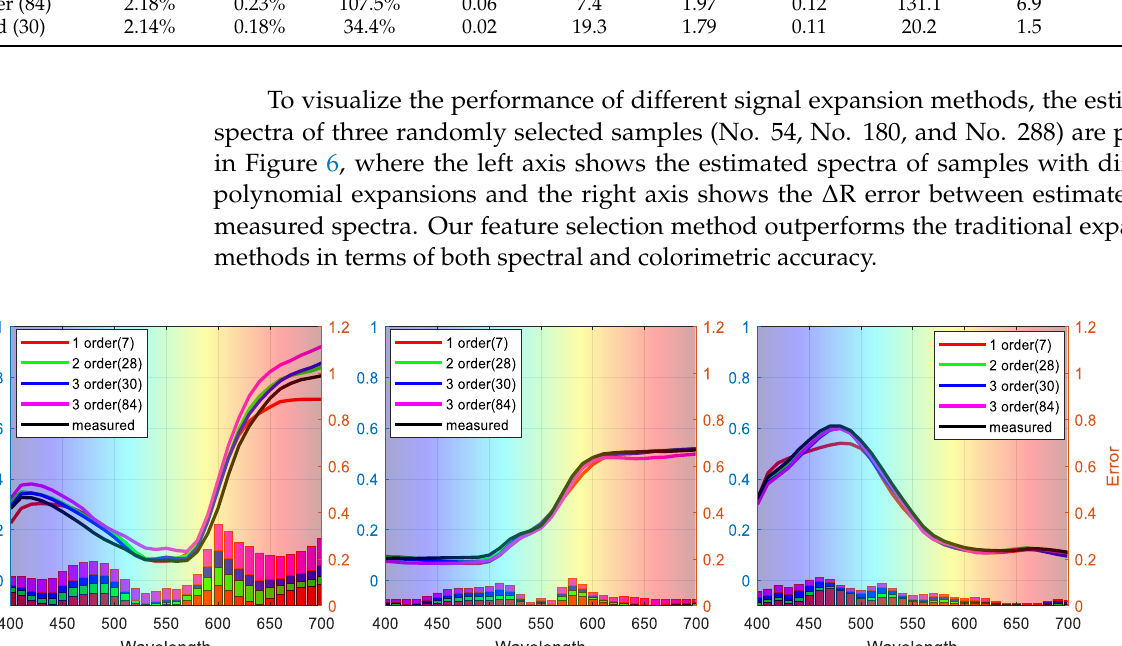
pansions. Table 2. Performance of reflectance estimation using two illuminants with different polynomial expansions.